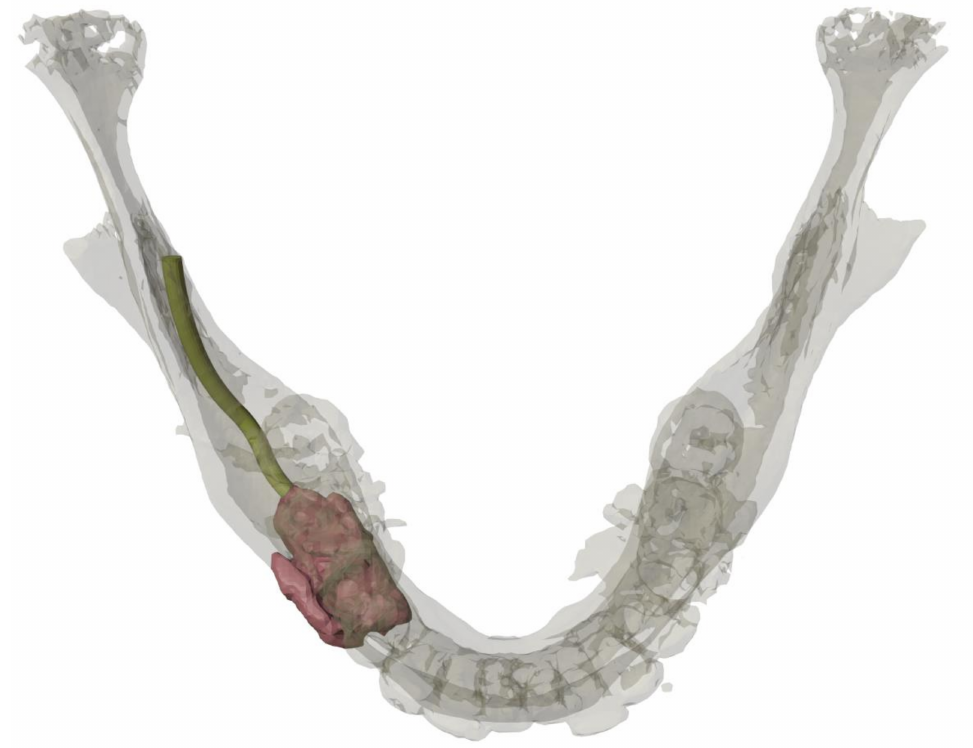
Figure 2. CT reconstruction of the mandible showing the nerve course and the osteolytic lesion on the right side of the mandible.